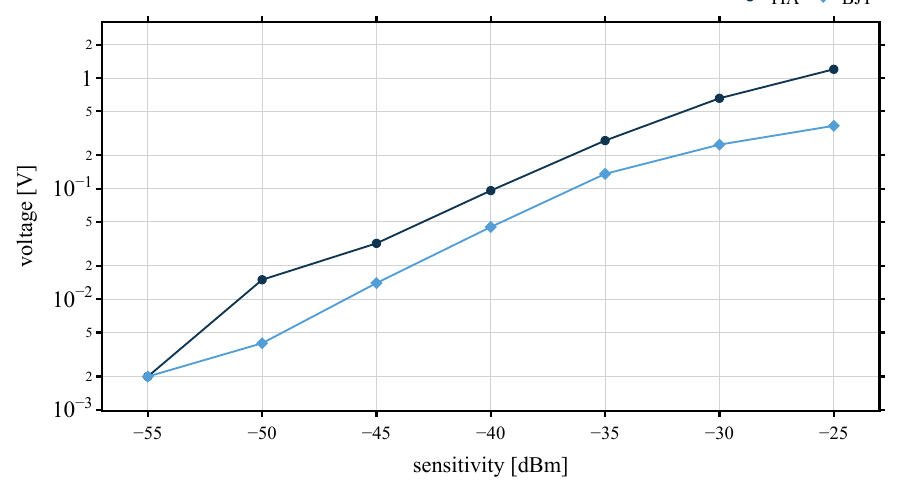
Figure 18. Amplification level of BJT and TIA architecture.